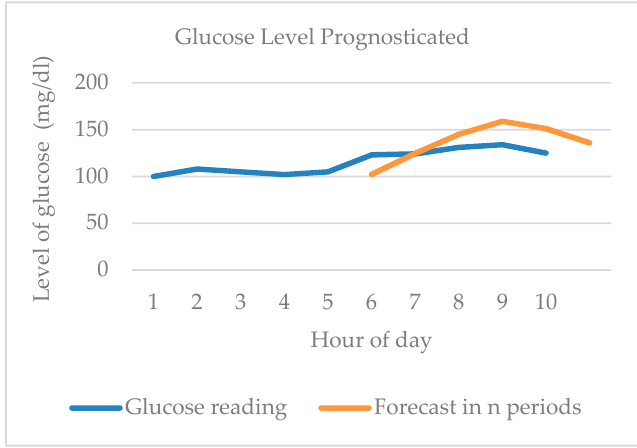
Figure 5. Glucose level prognosticated using the double moving average under normal conditions.